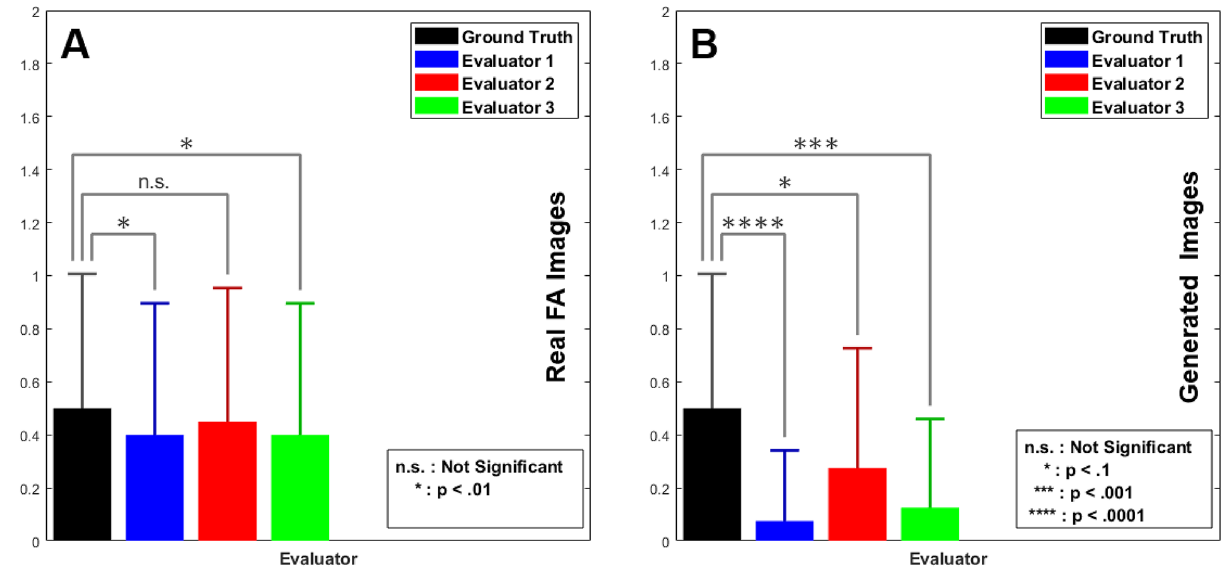
Figure 10. Expert evaluation of real versus generated FA images, given real FA images ( A ) and FA images generated by our proposed approach ( B ). Experts had difficulty distinguishing between real and generated FA images. For real images, two out of three experts had significantly lower correct classification compared to the ground truth ( p < .1 ). Given generated images, all experts had significantly lower correct classification scores compared to the ground truth ( p < .1 , p < .001 , and p < .0001